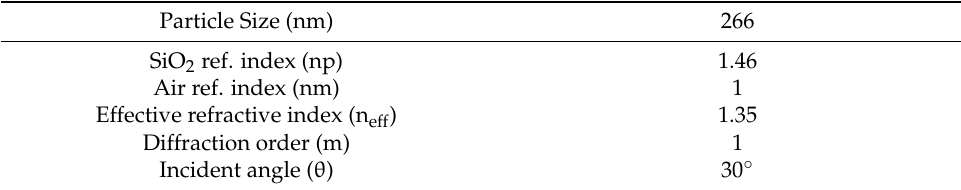
Table 1. C-PC’s physical